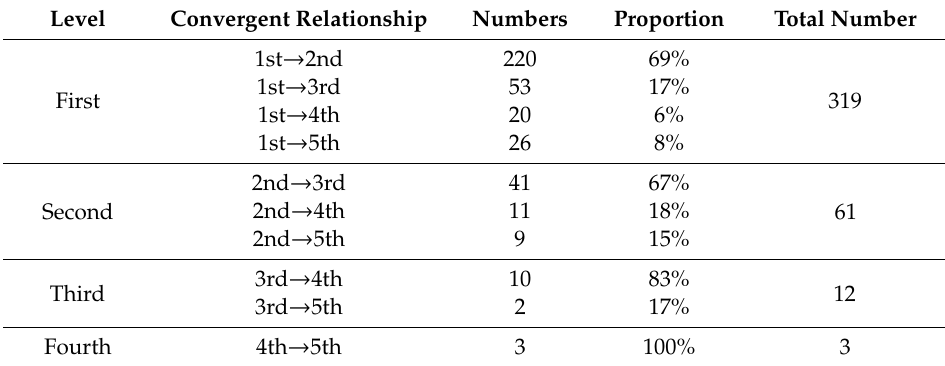
Table 6. Convergent relationship among di ff erent levels of valley gullies. Level Convergent Relationship Numbers Proportion Total